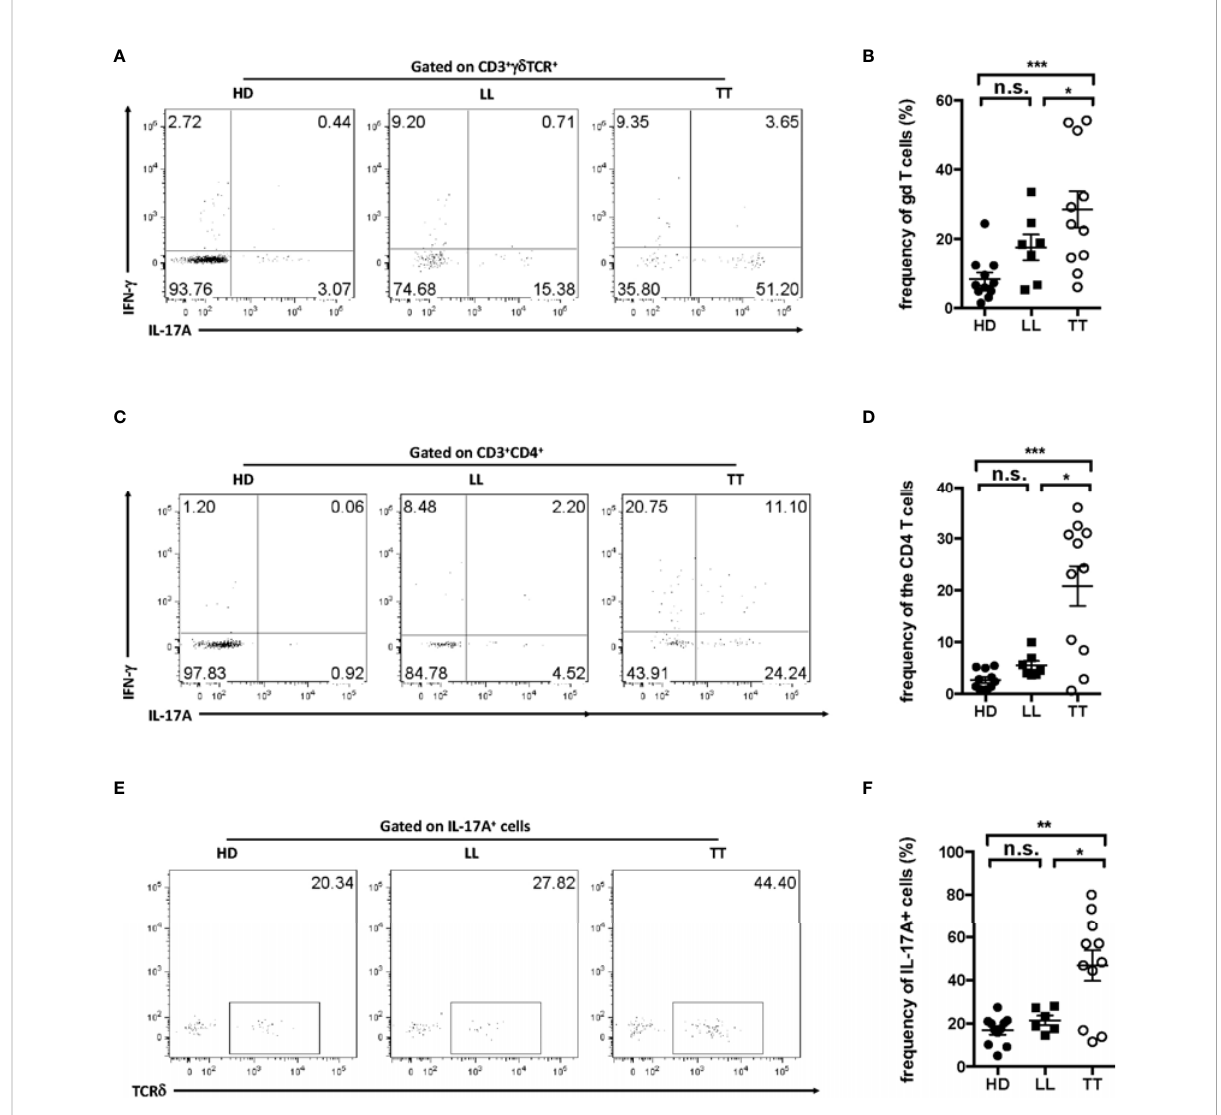
FIGURE 2 Dermal gd T cells were predominant IL-17 – producing cells in leprosy lesion. Intracellular IL-17A production was assessed by fl ow cytometry on dermal cell suspensions from leprosy lesion and healthy skin. (A) Representative plots showed expression of IL-17A and IFN- g in gd T cells. (B) Statistical results in (A) . (C) Representative plots showed expression of IL-17A and IFN- g in CD4 T cell. (D) Statistical results in (C) . (E) Representative plots showed TCR d + cells among IL-17A + cells. (F) Statistical results in (E) . Percentage was shown as mean ± SEM. Statistical analysis was performed by t -test. n.s.: no signi fi cance; * p < 0.05; ** p < 0.01; *** p <